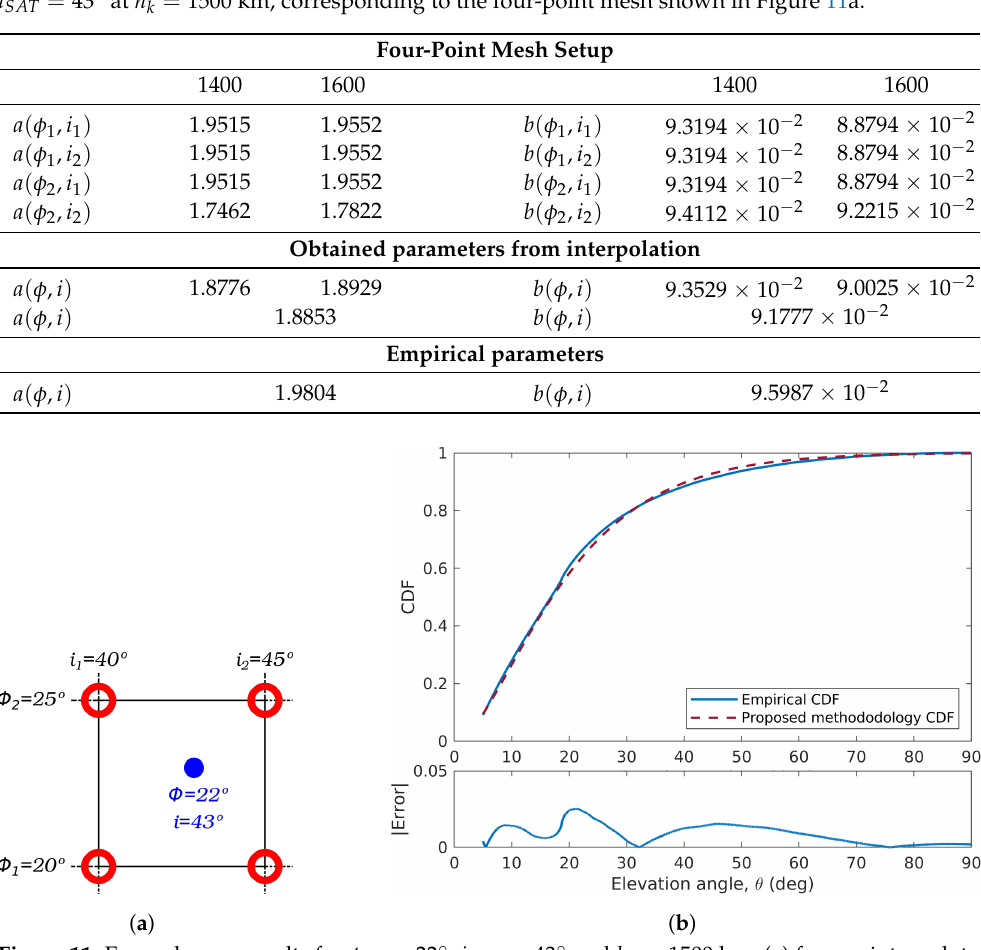
Figure 11. Example case results for φ ES = 22 ◦ , i SAT = 43 ◦ and h k = 1500 km: ( a ) four-point mesh to calculate the shape, a , and scale, b parameters of f θ ( θ ) and ( b ) empirical CDF vs. CDF obtained with the proposed